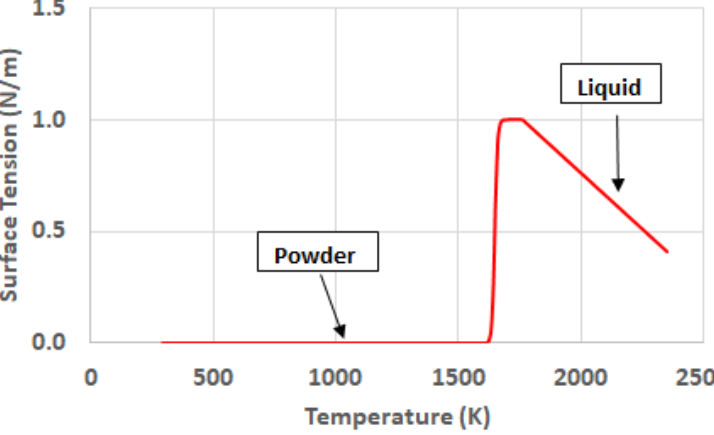
Figure 9. Phase and temperature dependency of the surface tension.